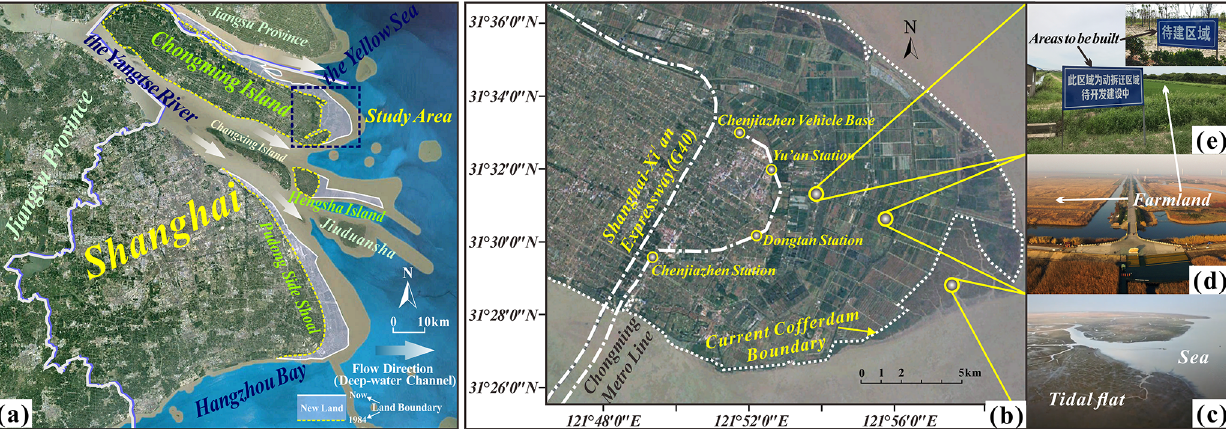
Figure 1. © Google earth image based study area: (a) geographical location of Chongming East Shoal in Shanghai, China; (b) ground characteristics of Chongming East Shoal and the projects to be built; (c) growing tidal-flat areas; (d) major land type and (e) construction land in planning.